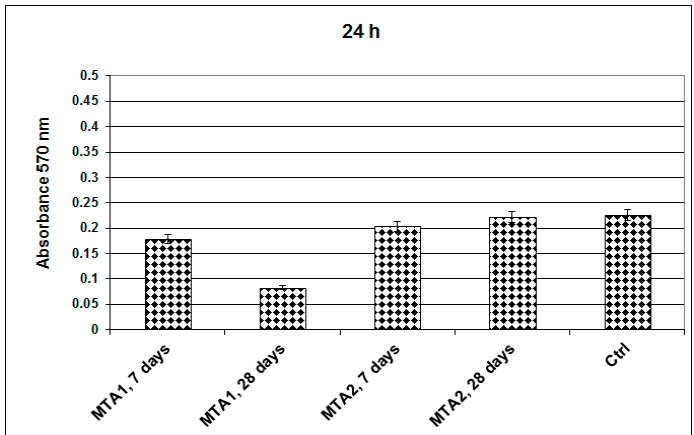
Figure 12. SEM micrographs of MTA pastes hydrated for 7 days and the immersed SBF for 14 days at 37 °C: ( a ), ( b )—MTA1; ( c ), ( d